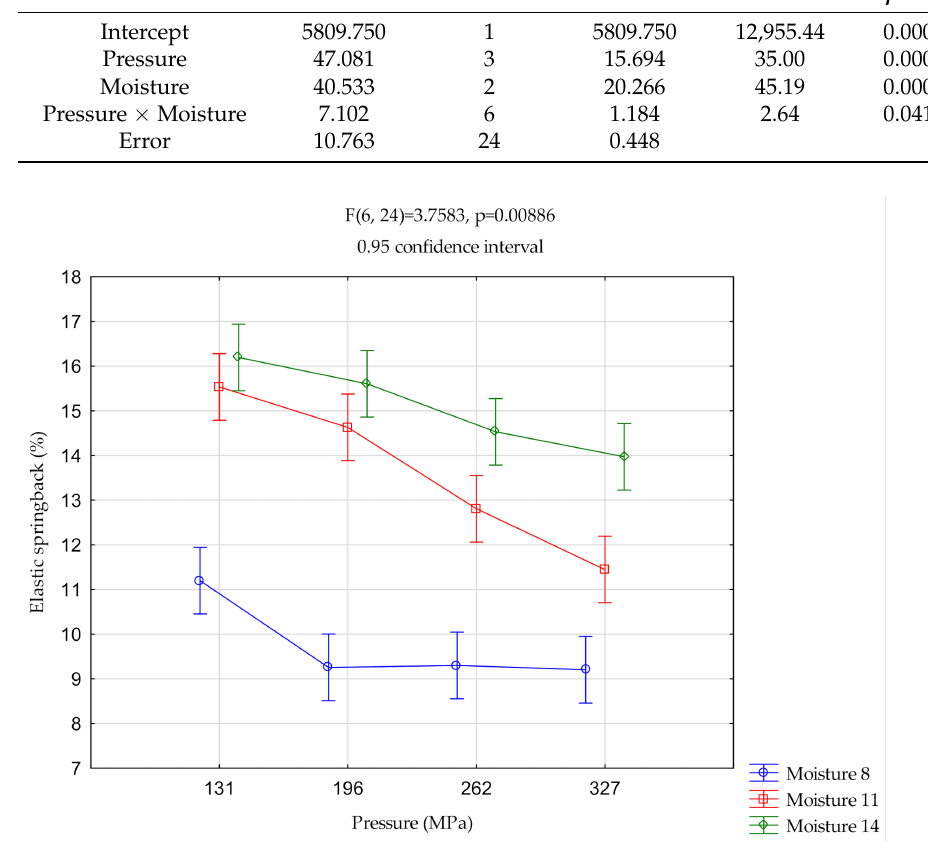
Figure 2. Two-way analysis of variance